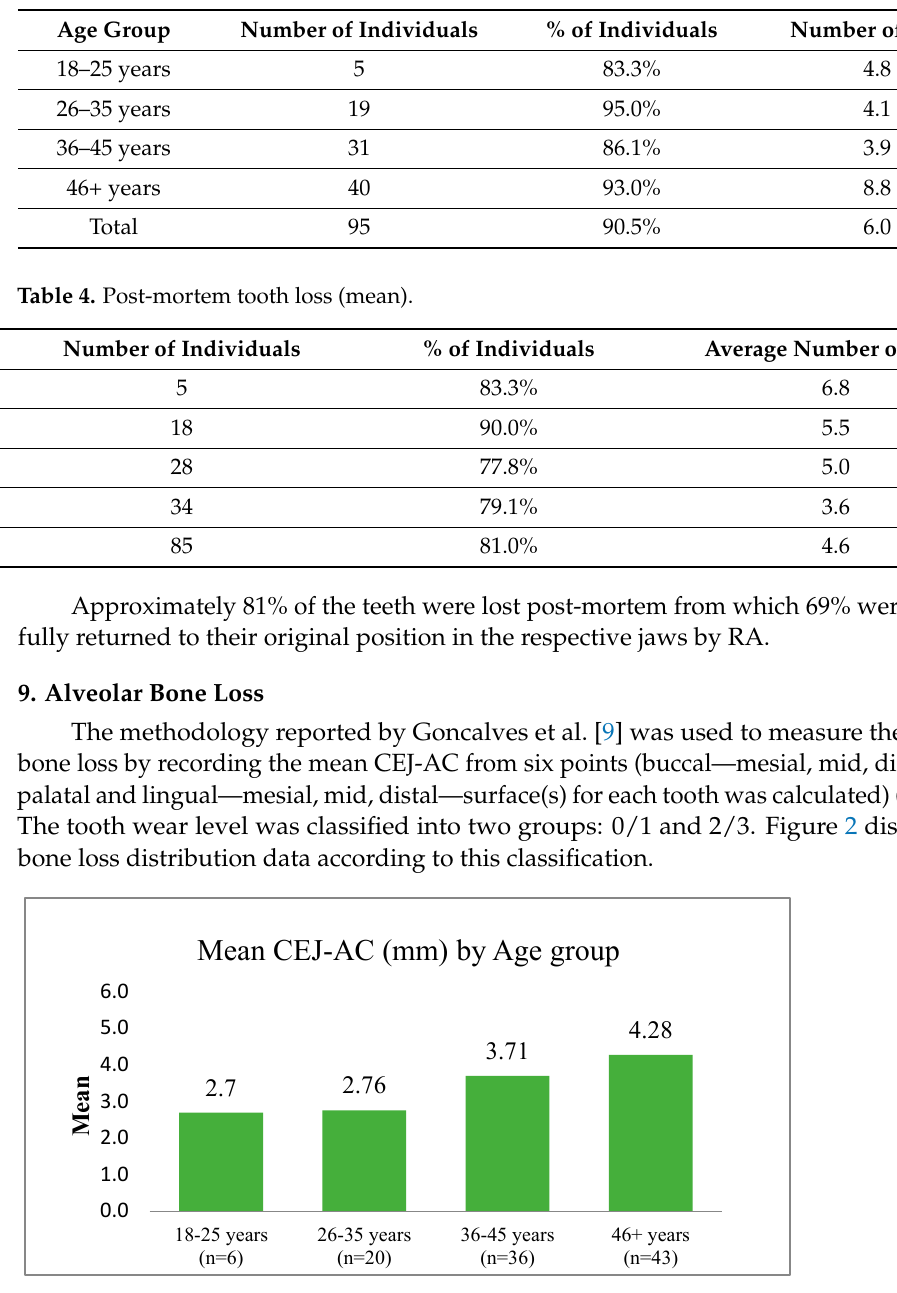
Figure 2. Mean CEJ – AC (mm) by tooth wear (mean CEJ-AC distance by age group for all teeth, teeth with wear 0/1, and teeth with wear 2/3). A two-way ANOVA model was used to compare the CEJ-AC means by age and wear. Significant differences were obtained between the age groups ( p < 0.001, F-test), between the wear level groups ( p < 0.001, F-test) and by comparing age with wear ( p < 0.001, F-test). For age groups 18–25 and 36–45 years, differences reached statistical significance ( p < 0.001, B., p = 0.002, B.). No differences were observed for age groups 26–35 years ( p = 0.310, B.) and for 46+ years ( p = 0.243). The exception was in the age group 18–25 years old, where teeth with a higher level of wear (dark blue columns) were present with similar mean levels of CEJ-AC distance when compared to teeth with a lower wear grade (Figure 2, light blue columns). 10. Horizontal Bone Loss A total of 31.1% of the sample was affected with horizontal bone loss. Table 5 sum- marises the horizontal bone loss by age and sex. More males ( n = 27) were numerically affected with horizontal bone loss than females ( n = 12) with 40.9% and 30.8% individual bone loss respectively (Figure 3a,b).